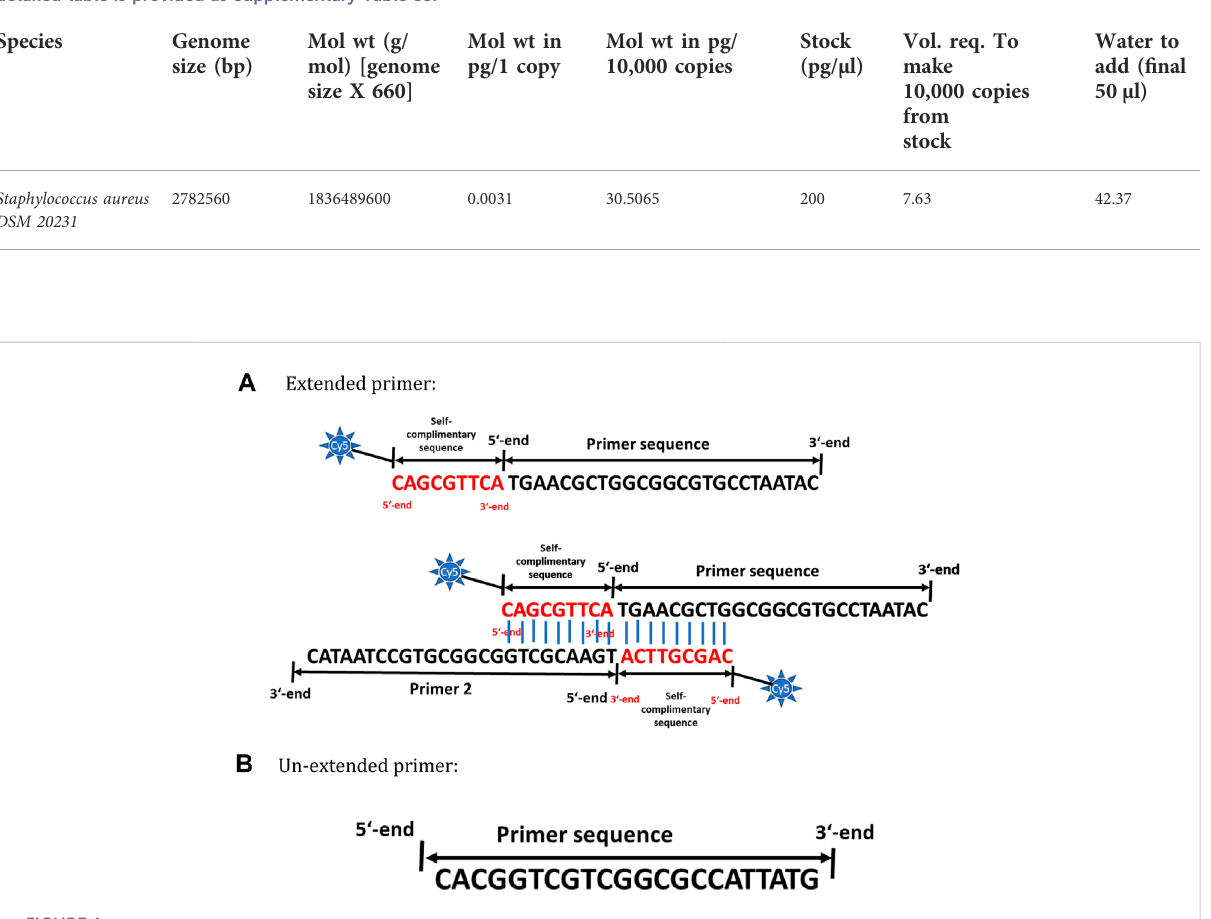
FIGURE 1 Primer design strategy for AELA PCR. (A) Schematic representation of the inverted self-complementary tail sequence at the 5 ′ end of extended primer sequence. The fi rst ninebases represented in red are complementary to the fi rst nine bases in order to allow self-hybridization of the primer. The blue lines represent the hydrogen bonding between the nucleotides. (B) Schematic representation of the un-extended primer